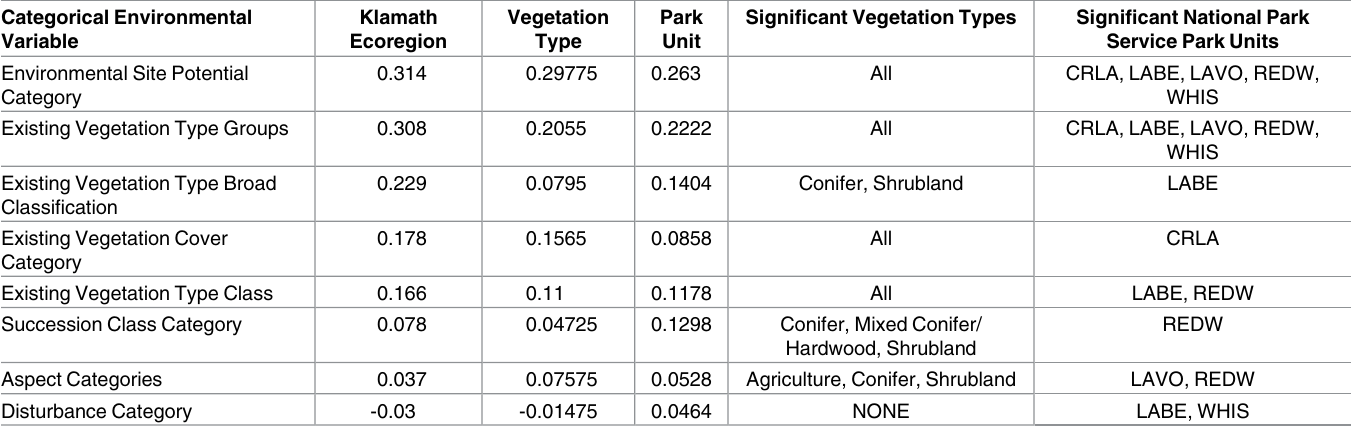
Table 2. Grouping Strength for Categorical Environmental